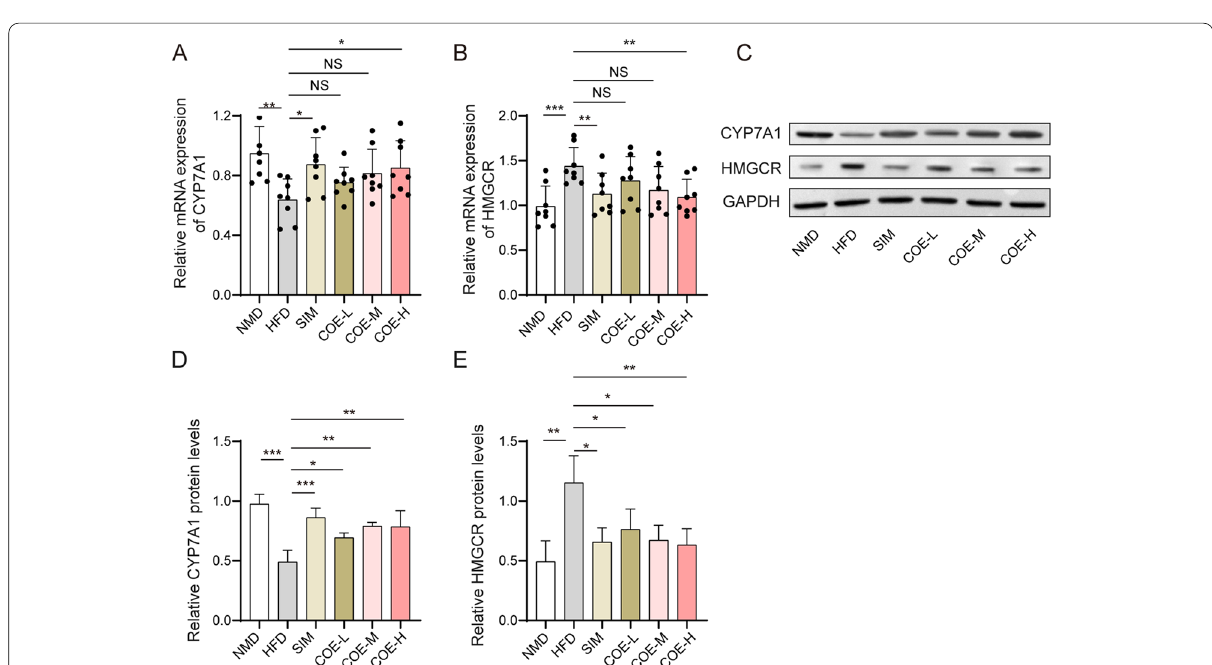
Fig. 6 Effects of COE on CYP7A1 and HMGCR expression. A CYP7A1 mRNA levels were determined by qPCR. B HMGCR mRNA levels were measured via qPCR. C , D CYP7A1 and HMGCR protein levels were assessed through western blot assays. n